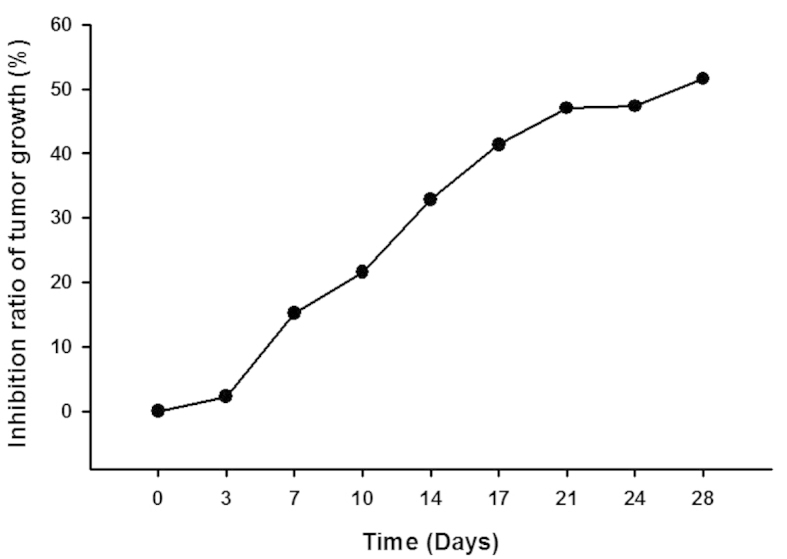
Mean inhibition ratio of tumor growth. The increase in the inhibition ratio was time-dependent.